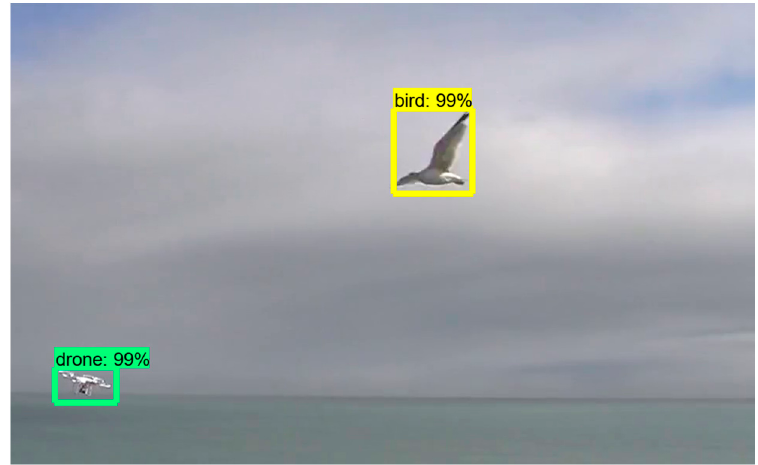
Figure 23. Testing the objects detection in the sky with an improved detector.